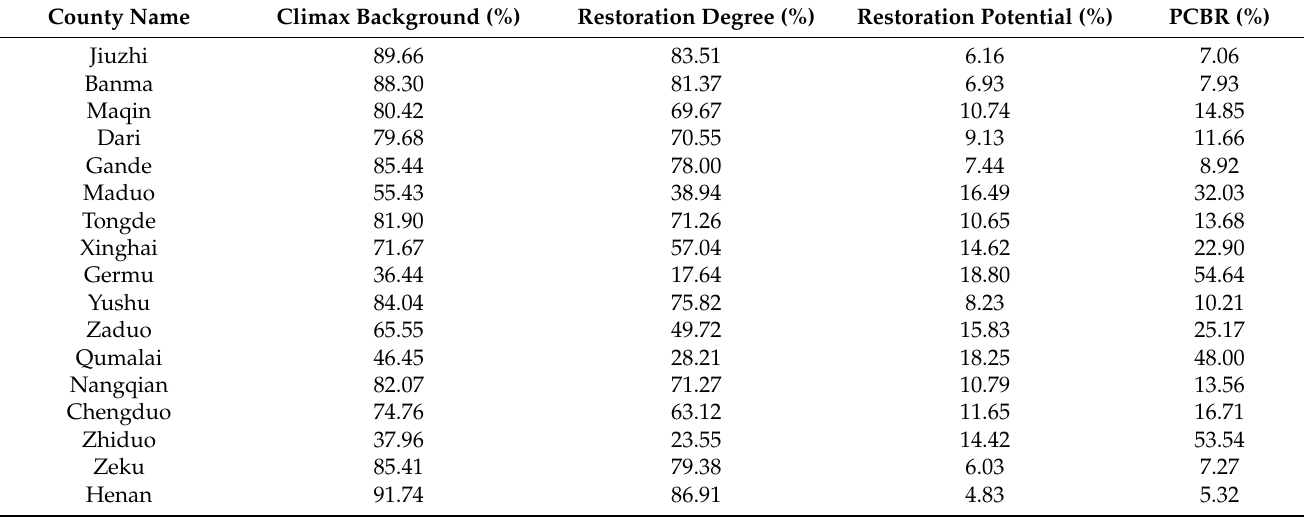
Table 2. Statistical table of climax background, restoration degree, restoration potential, and PCBR of FVC in TRHR’s